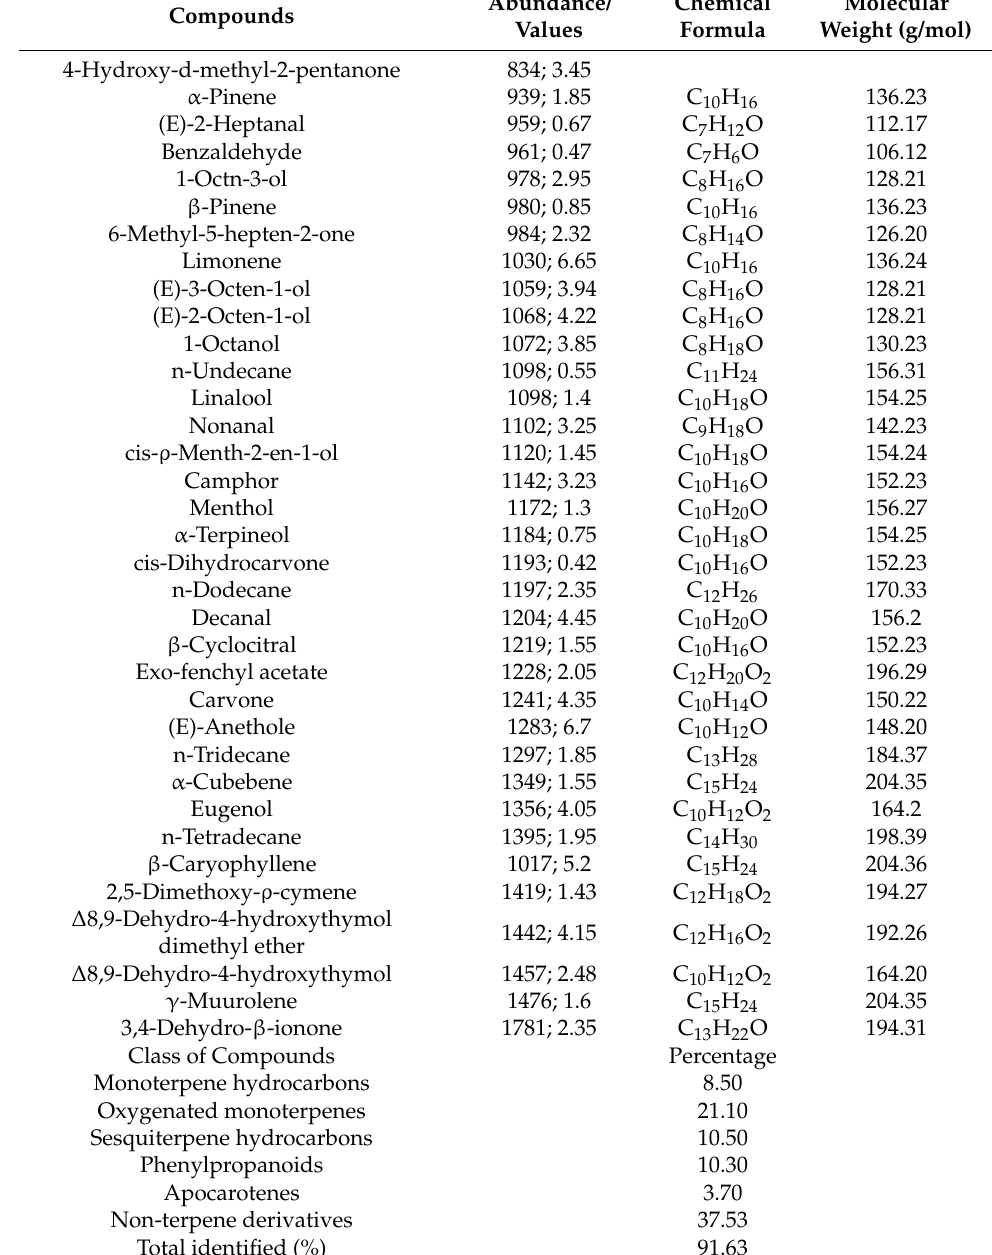
Table 4. GC–MS identification of phytoconstituents in Okra